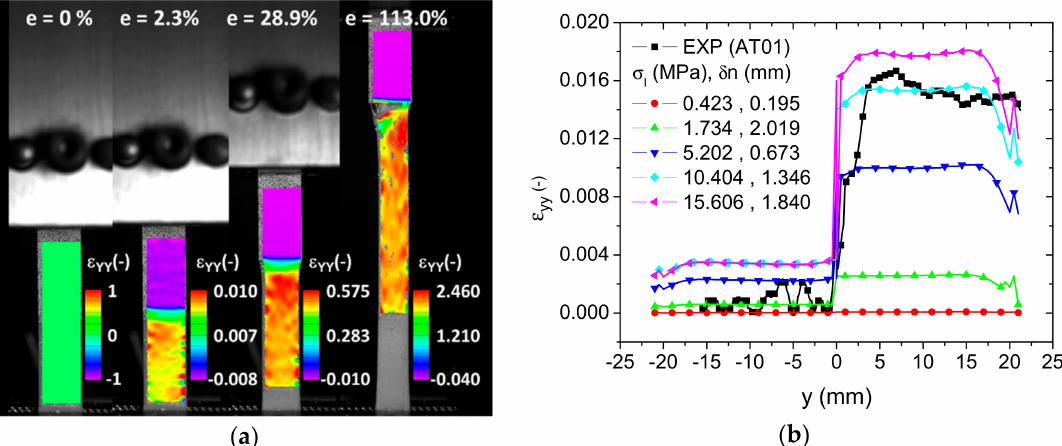
Figure 13. DIC-based results: ( a ) longitudinal strain component ε yy as a function of the load level e (height extension in percent) for AT01; ( b ) identification of the interface parameters ( σ I , δ n ) from the strain profile across the interface using DIC